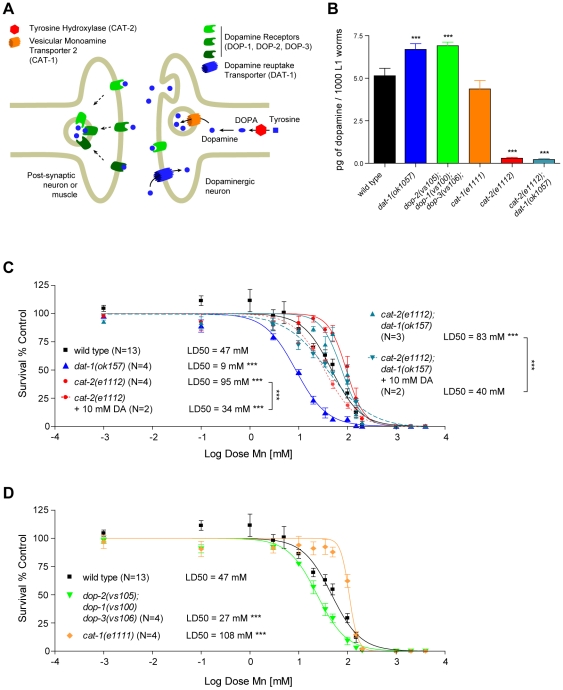
Increased extracellular, but not intracellular, dopamine levels confer hypersensitivity to Mn toxicity while decreased levels are protective.(A) Schematic representation of a generic dopaminergic synapse in C. elegans. (B) Total DA levels in selected mutants relevant to the study at the L1 larval stage. dat-1(ok157), dop-2(vs105);dop-1(vs100) dop-3(vs106) display significantly (p<0.001) higher dopamine levels than WT or other mutants, while dopamine measurement in cat-2(e1112) and dat-1(ok157);cat-2(e1112) did not reach a significant value compared to the background levels measured in our experiment. (C) dat-1(ok157) is hypersensitive (p<0.001) to Mn-induced lethality, with a LD50 = 9 mM. cat-2(e1112) is hyper-resistant (p<0.001) to Mn-induced lethality, with a LD50 = 95 mM. cat-2(e1112) rescues dat-1(ok157) hypersensitivity in the double-mutant cat-2(e1112); dat-1(ok157), which LD50 = 83 mM is not significantly different from cat-2(e1112) mutant. 10 mM DA pre-treatment restores Mn sensitivity (p<0.001) in both cat-2(e1112) and cat-2(e1112);dat-1(ok157), with respective LD50 of 34 mM and 40 mM. (D) The VMAT2 mutant cat-1(e1111) exhibits hyper-resistance to Mn (p<0.001), with a LD50 = 108 mM; while the DA receptor mutant dop-2(vs105);dop-1(vs100) dop-3(vs106) is hypersensitive to Mn exposure (p<0.001), with a LD50 = 27 mM.